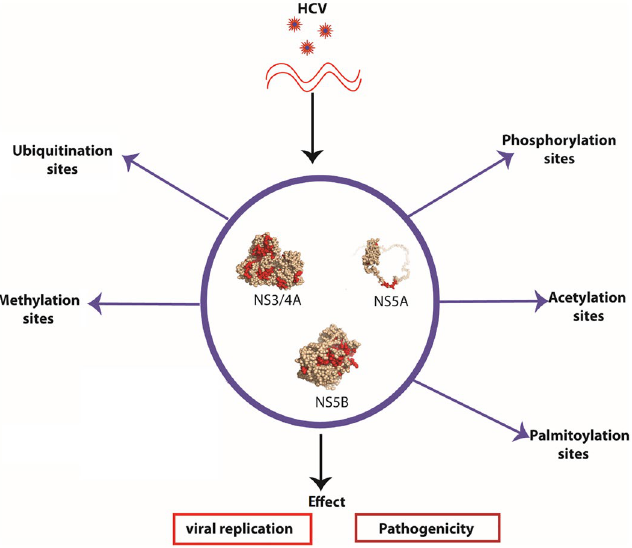
Figure 1. Schematic illustration of potential PTMs within HCV NS3/4A, NS5A, NS5B. The PTMs significantly affect the viral replication and